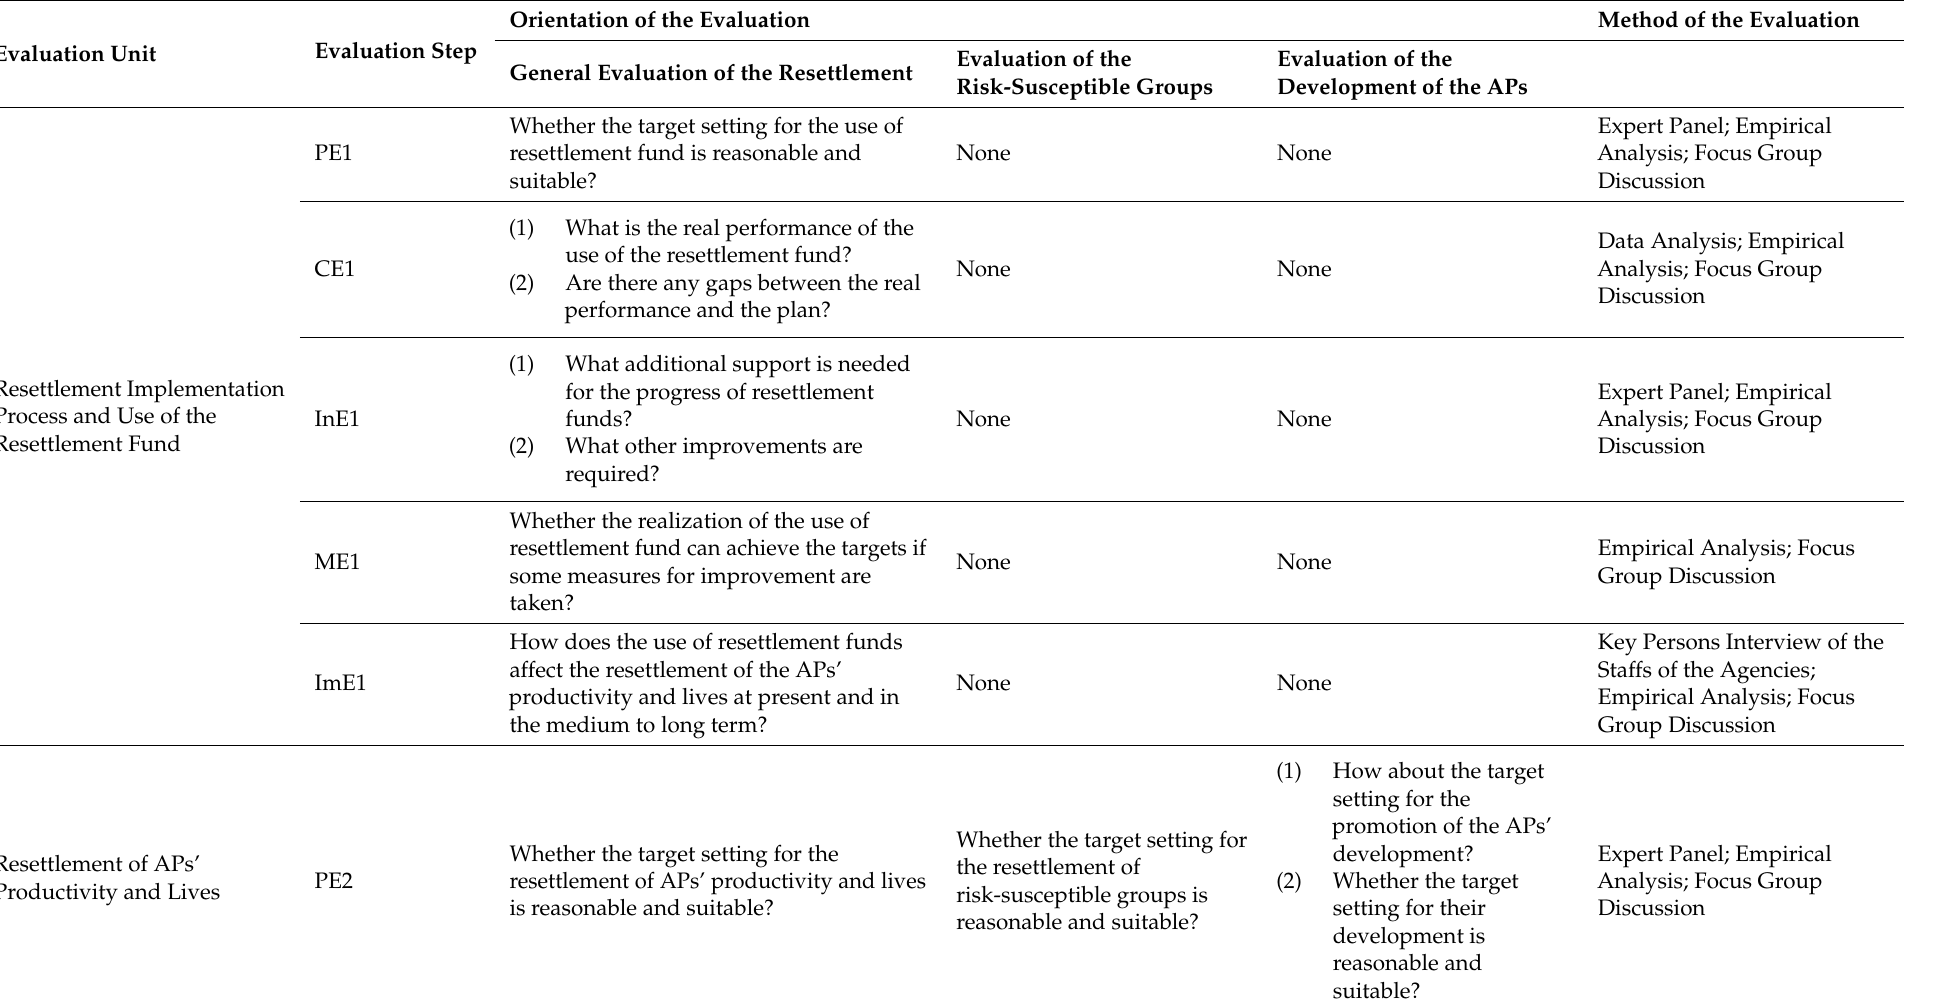
Table 3. The Updated Evaluation Model of Involuntary